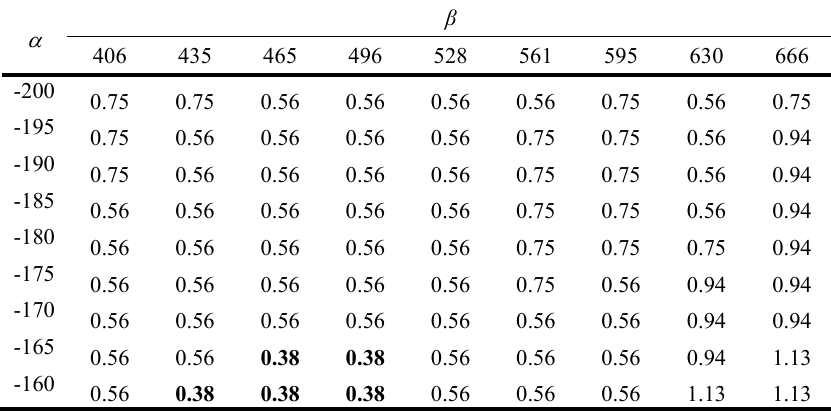
Table 3(a). Variation in percentage error rate for some values of α and β on subset 4 of extended Yale B face